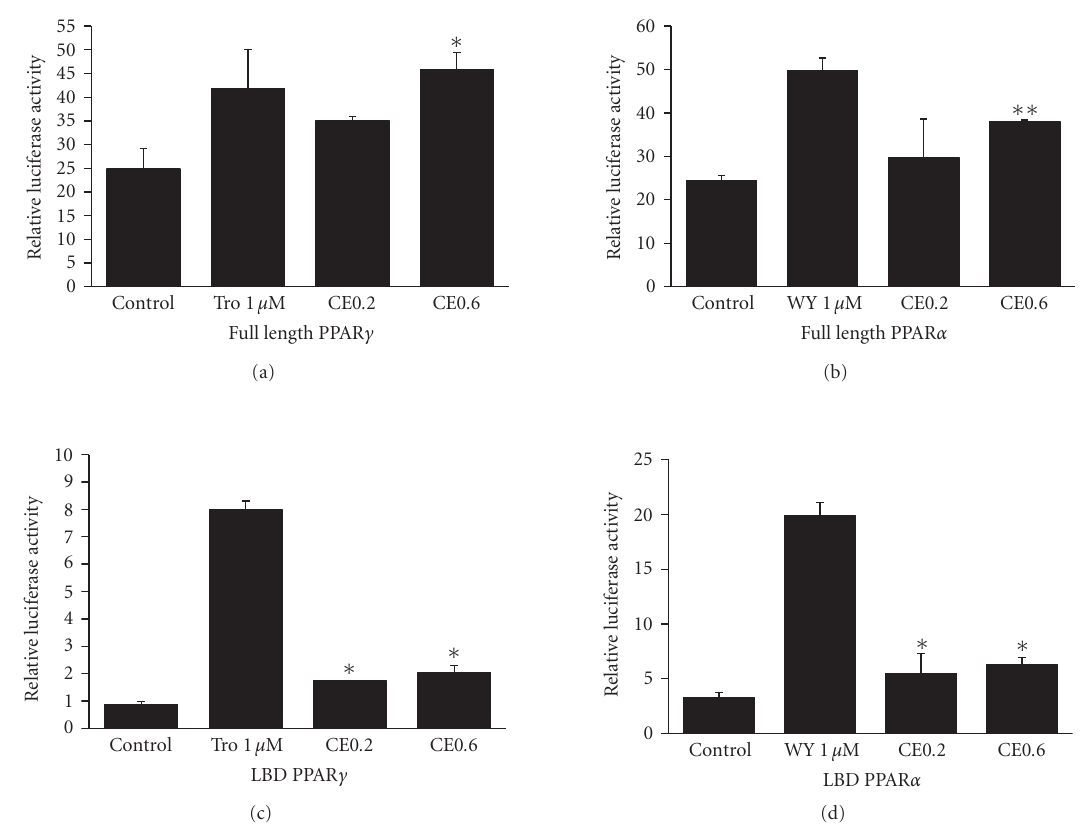
Figure 4: CE activated transactivities of PPAR γ and PPAR α . Full-length PPAR γ or PPAR α was cotransfected with PPRE-J3-TK-Luc reporter construct to 293T cell and treated with CE (0.2mg/mL, 0.6mg/mL), 1 μ M of troglitazone or WY-14643 for 24 hours as positive controls. Rellina luc was used as a transfection e ffi ciency control and the relative luciferase activities were measured against renilla luciferase activities. For LBD activity assay, pMCX-GAL4-LBD of PPAR γ or α expression constructs were cotransfected with USA G × 4-TK-Luc into 293T using the same protocol as described above. The empty vectors were used as control. (a) Full-length PPAR γ . (b) Full-length PPAR α . (c) LBD PPAR γ . (d) LBD PPAR α . The results represent three independent experiments. Data are presented as mean ± SE. ∗ P < . 05, ∗∗ P < . 01. Tro: troglitazone; WY: WY14643.